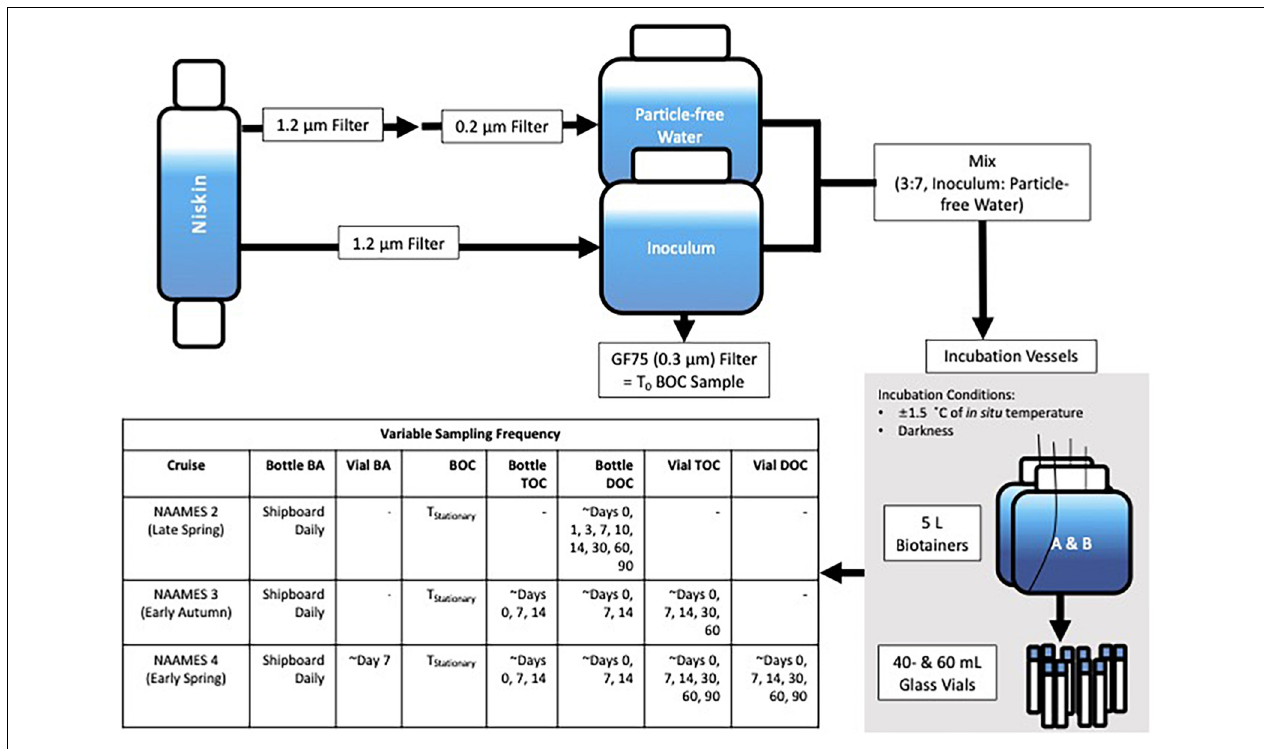
FIGURE 2 | Schematic of the initiation and incubation conditions of the DOC remineralization experiments conducted on NAAMES 2–4, detailed in section “Dissolved organic carbon Remineralization Experiments.” Also included is a table of the sampling frequency for the incubations, in which bacterioplankton abundance is denoted by “BA,” bacterioplankton organic carbon by “BOC,” total organic carbon by “TOC,” and dissolved organic carbon by “DOC.” “ T 0 ” refers to the initial condition of the experiment while “ T Stationary ” refers to the stationary phase of cell growth determined by the bacterioplankton abundance curve. Note that T 0 BOC was collected from the inoculum while T Stationary BOC was collected from the bottle